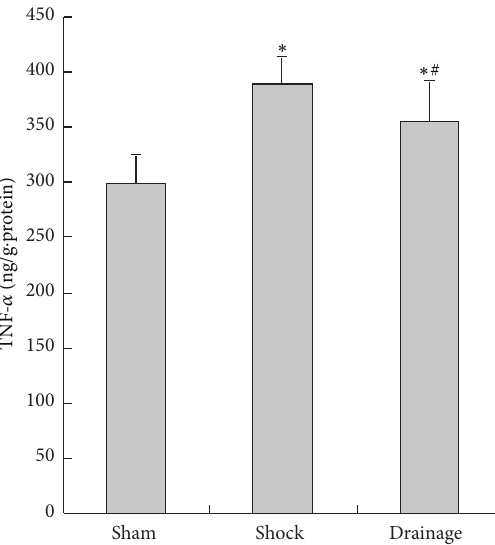
Figure9:EffectsofmesentericlymphdrainageonTNF- 𝛼 contentof renal homogenate in hemorrhagic shock rats without resuscitation (ng/g ⋅ protein, mean ± SD, 𝑛 = 6 ). ∗ 𝑃 < 0.05 versus sham group; # 𝑃 < 0.05 versus shock